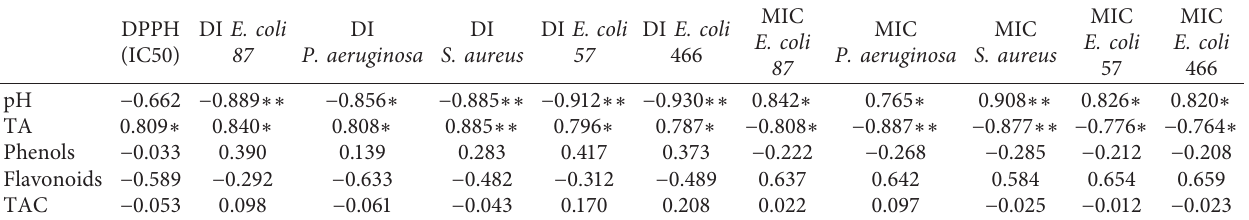
Table 4: Pearson correlation coefficients between the assessed physicochemical parameters and diameter of inhibition (DI) and MICs of vinegar samples.